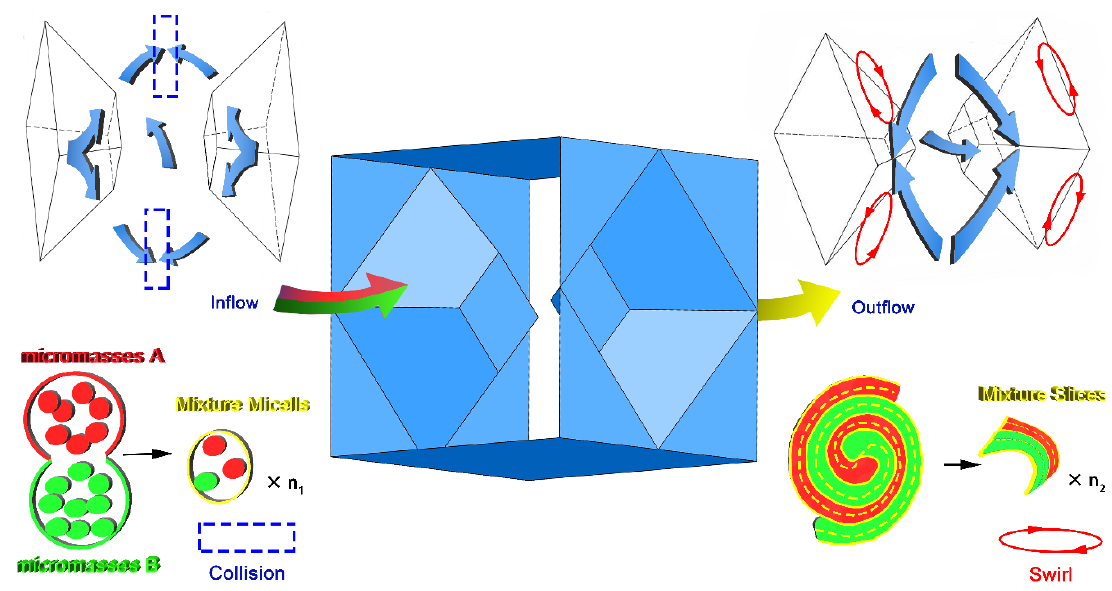
Figure 12. Scheme of splitting-collision mechanism.